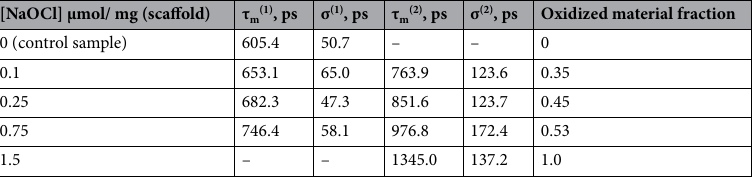
Table 1. Fitting of the mean fluorescence lifetime distributions τ m of the DPB-G scaffolds treated with NaOCl using Gaussian mixture model. Parameters τ m(1) and τ m(2) represent the position of the maximum of the corresponding Gaussian curves, while σ (1) , σ (2) represent the characteristic Gaussians’ widths. An oxidized material fraction was estimated as a fraction of pixels attributed to the cluster with a longer lifetime (i.e., cluster